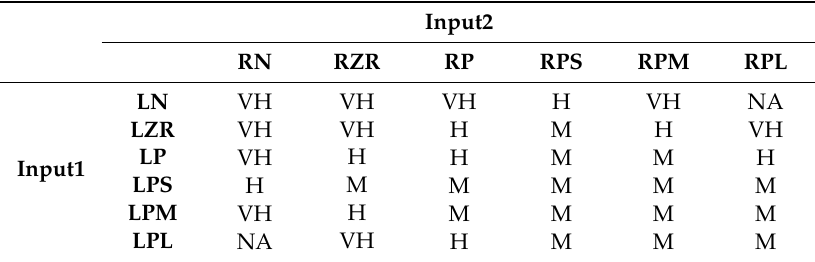
For the inputs: LN, left negative; LZR, left zero; LP, left positive; LPS, left positive small; LPM, left positive medium; and LPL, left positive large (similarly for the right (R) inputs). For the outputs: VL, very low; L, low; M, medium; H, high; VH, very high; and NA, not applicable. Table 2. Fuzzy rules set for the stance